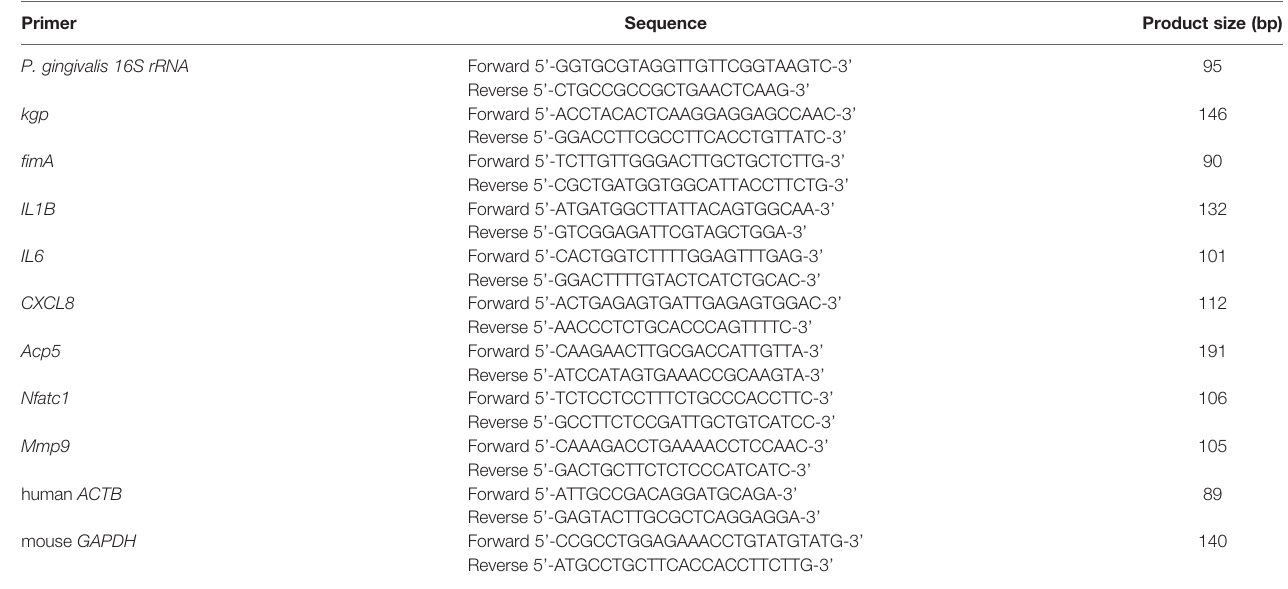
TABLE 1 | Primers used for